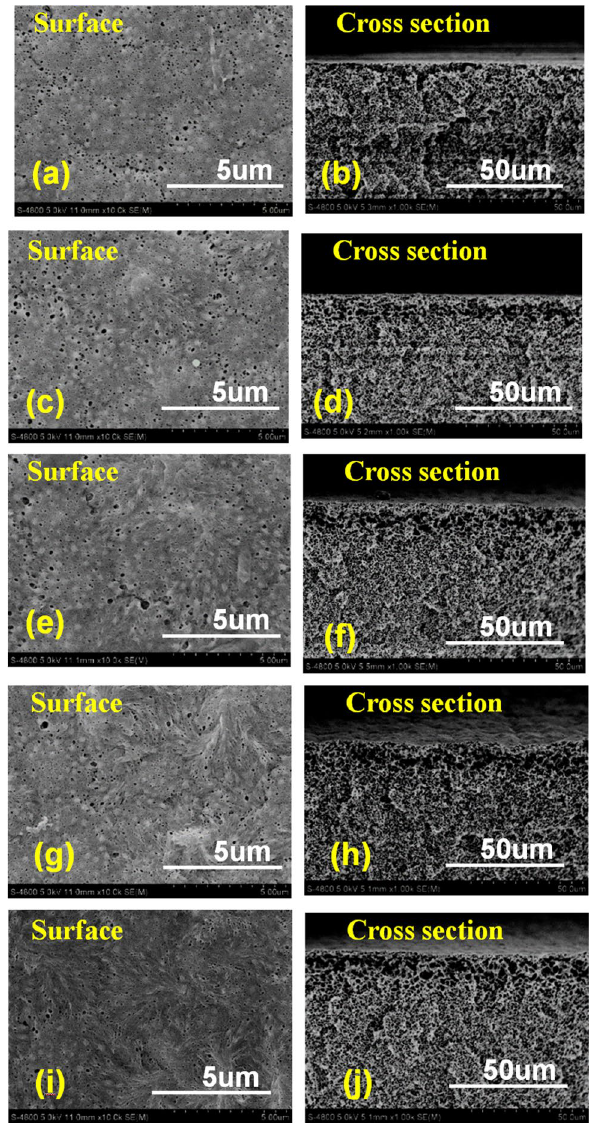
Fig. 8 Surface and cross section SEM images of membranes prepared